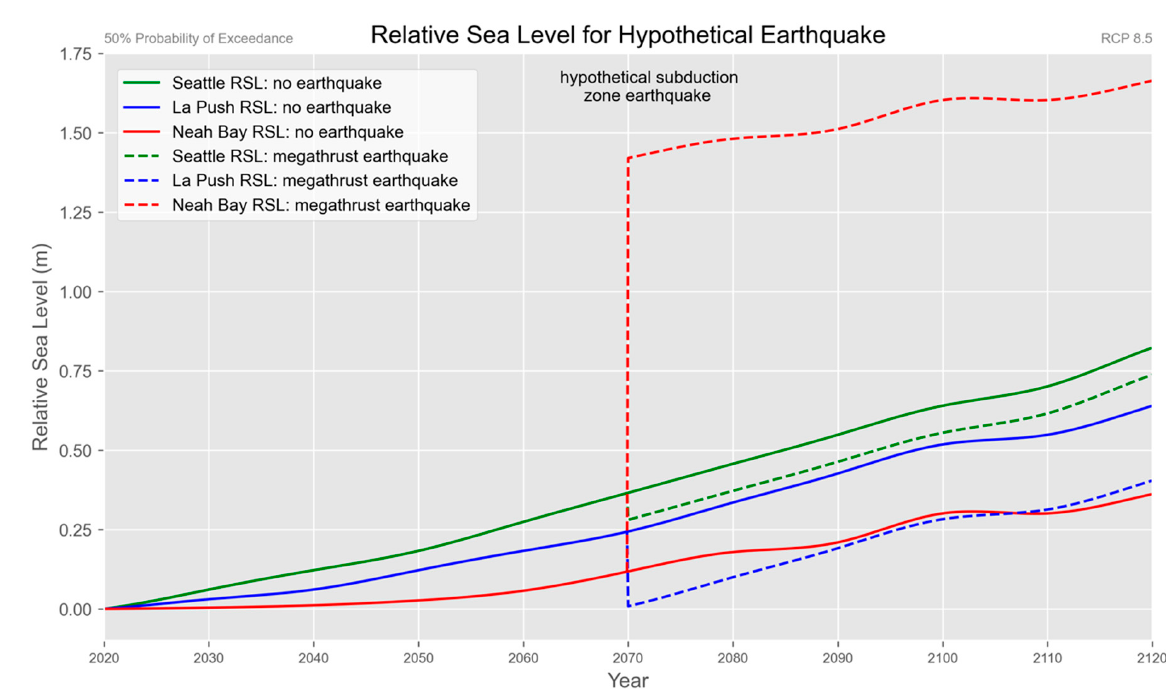
Figure 9. Relative sea level (RCP 8.5 and a 50% probability of exceedance) over time with and without a hypothetical megathrust rupture at 2070 to exhibit the effect of coseismic land change on relative sea level at La Push, Neah Bay, and Seattle. Coseismic land change is assumed to equal the sum of our estimated annual vertical deformation rate due to the Cascadia subduction zone summed over the hypothetical interseismic period, with the opposite sense of motion. We assume no postseismic viscoelastic relaxation for the purpose of this visualization. The hypothetical earthquake and associated coseismic land changes will produce an instantaneous shift in RSL, and areas experiencing rapid uplift, like Neah Bay, will see a dramatic increase in RSL. Regions that are subsiding west of the zone of interseismic uplift, like La Push, are expected to experience coseismic uplift and will see a decrease in RSL after a major subduction zone earthquake. Regions well east of the subduction zone, such as Puget Sound and Seattle, are expected to experience minor uplift.